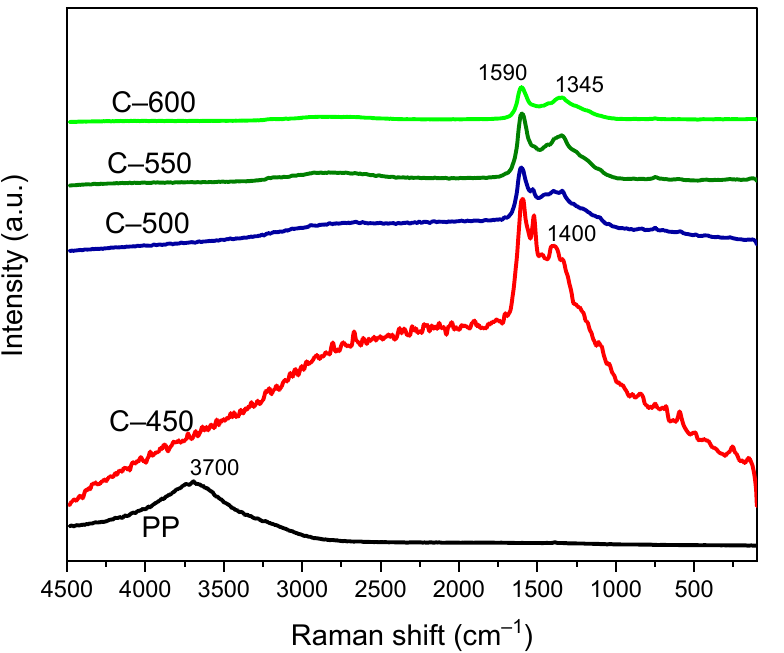
Figure 8. Raman spectra of raw PP-IG and char samples were obtained at different operating tem- peratures.